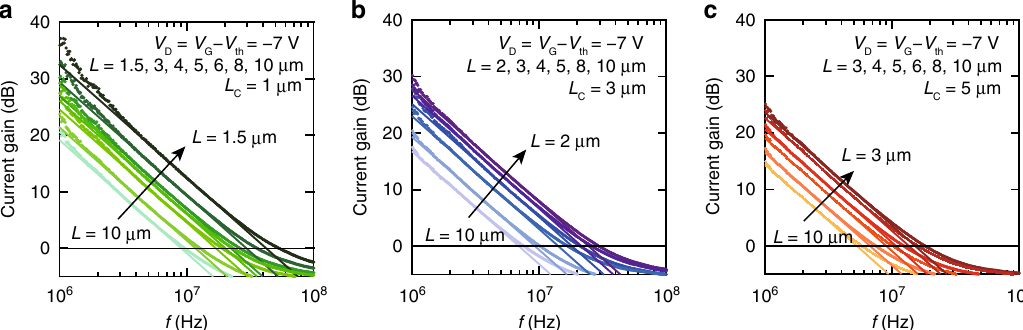
Fig. 4 Dependence of the cut-off frequency with respect to OFET geometrical factors. Plots of current gain as a function of frequency with different channel lengths ( L ) and contact lengths ( L C ). a L C = 1 μ m, b L C = 3 μ m, c L C = 5 μ m.